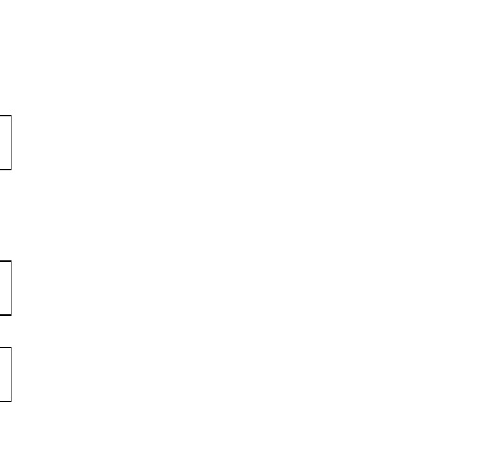
Figure 1. Division of the thoracic aorta. Pre-TAVI CTA “stretched vessel” reconstruction for division of the thoracic aorta into three sections: (1) Ascending aorta (annular plane to proximal origin of brachiocephalic artery); (2) Aortic arch (proximal origin of brachiocephalic artery to distal origin of left subclavian artery); (3) Proximal descending thoracic aorta (distal aortic arch end to the plane at transverse level of the annular plane).